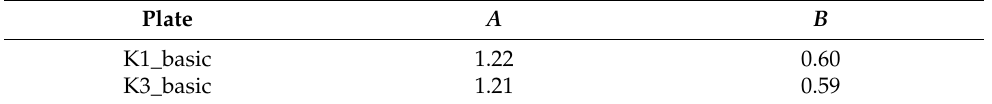
Table 3. Coefficients for the Mach number pressure drop dependency for ‘revised’ plate setting.